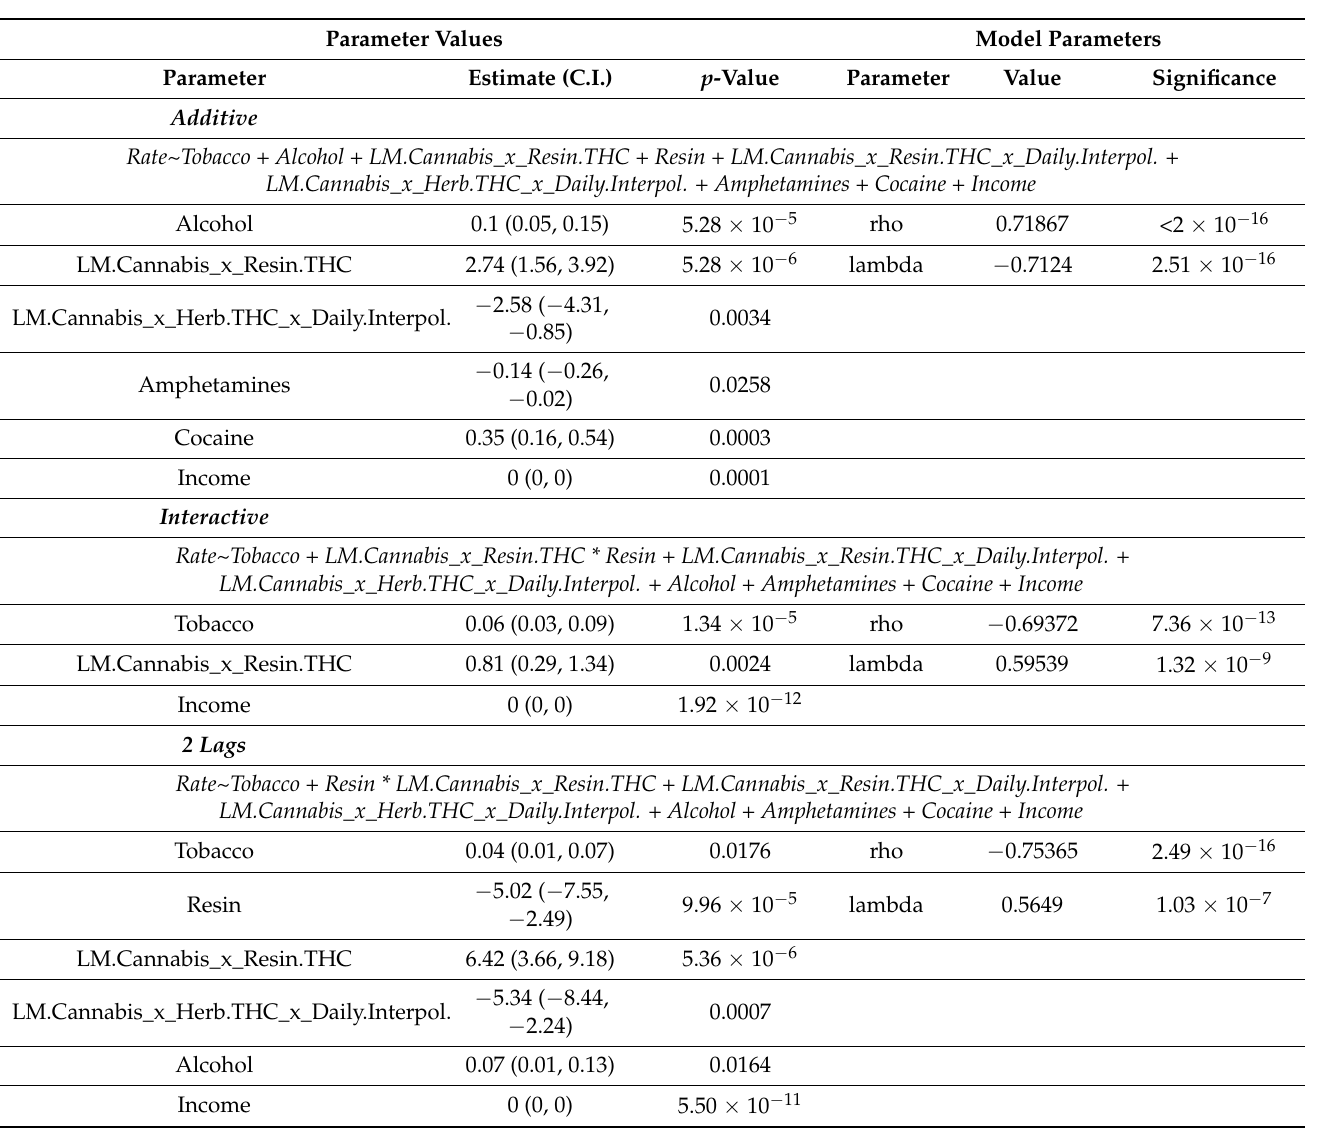
Table 3. Geospatiotemporal Models for Omphalocele.